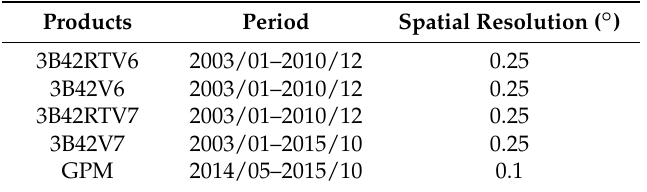
Table 1. Introduction of the five kinds of satellite precipitation